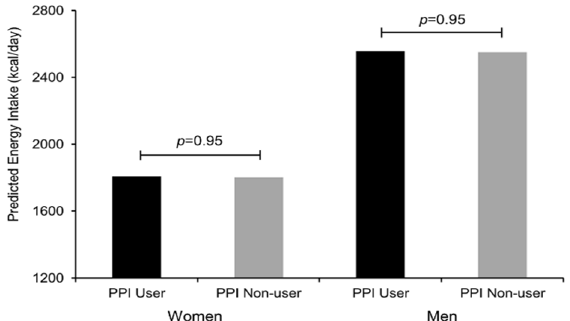
Figure 1. Energy intake (kcal/day) by proton pump inhibitor use for adult men and women in the National Health and Nutrition Examination Survey (NHANES) 2005–2006. Adjusted for use of insulin, non-insulin diabetic medications, use of lipid-lowering medications, antidepressant use, self-assessment of physical activity relative to peers, number of non-psychiatric/non-diabetic drugs, BMI Note: y-axis starts at 1200 kcal/day.